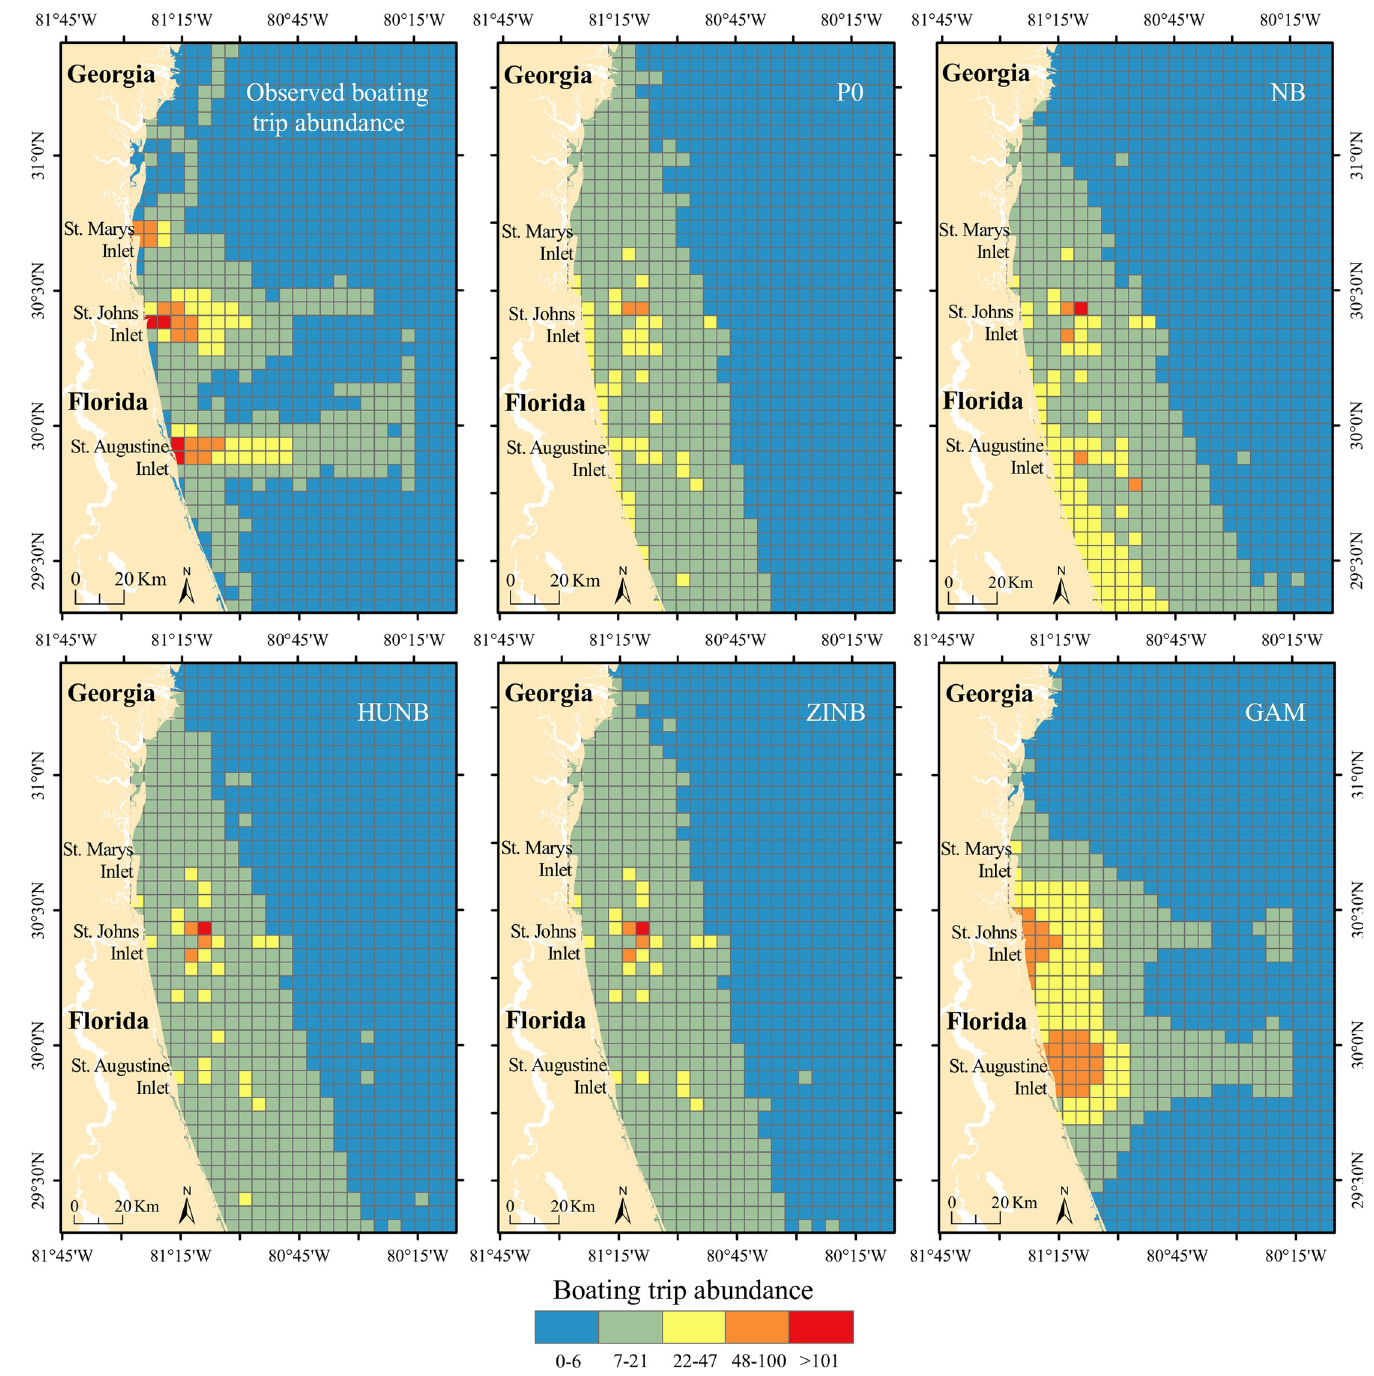
Fig 2. Observed and predicted boating trip abundance generated by different models for the winter season: Poisson model (PO), negative binomial model (NB), hurdle negative binomial model (HUNB), zero inflated negative binomial model (ZINB), and generalized additive model (GAM). https://doi.org/10.1371/journal.pone.0208126.g002 in Fig 5. In this case, the cumulative predicted values reached maximum values closer to the observed (cumulative value predicted by GLMM = 154; Max value observed = 174). Areas near the St. Augustine, St. Johns, and St. Marys inlets show the highest predicted values.